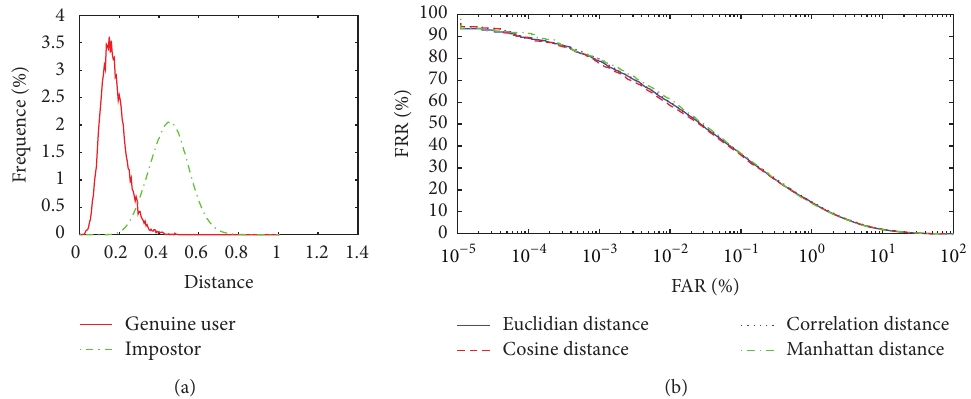
Figure 11: (a) Distribution of the genuine user and impostor based LBPV LPP using Manhattan classifier. (b) ROC curve based LBPV LPP to different classifiers.